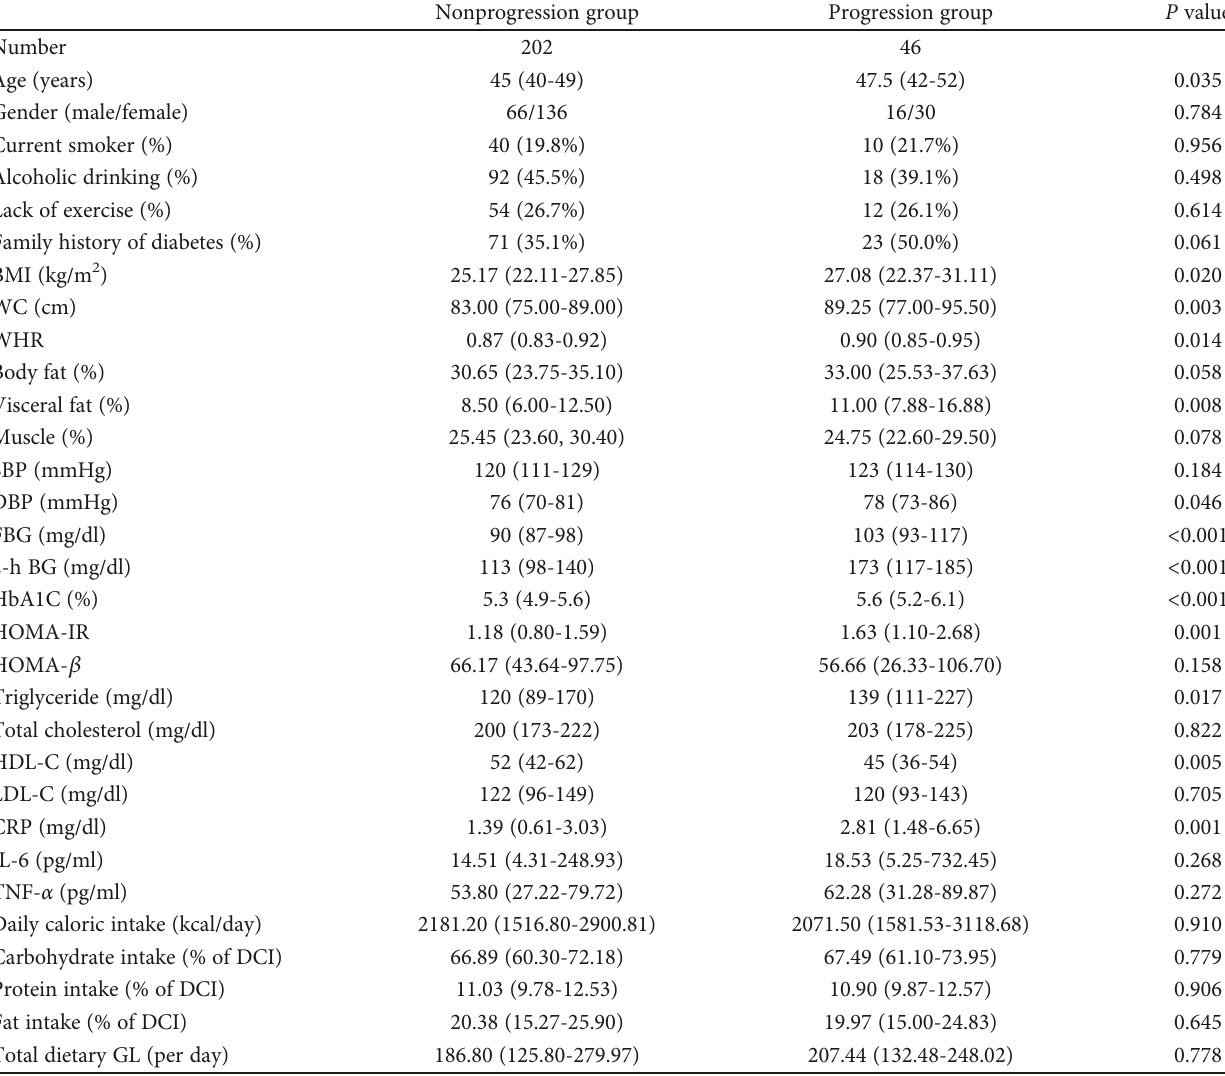
Table 1: Baseline characteristics of study subjects in longitudinal analysis based on progression to